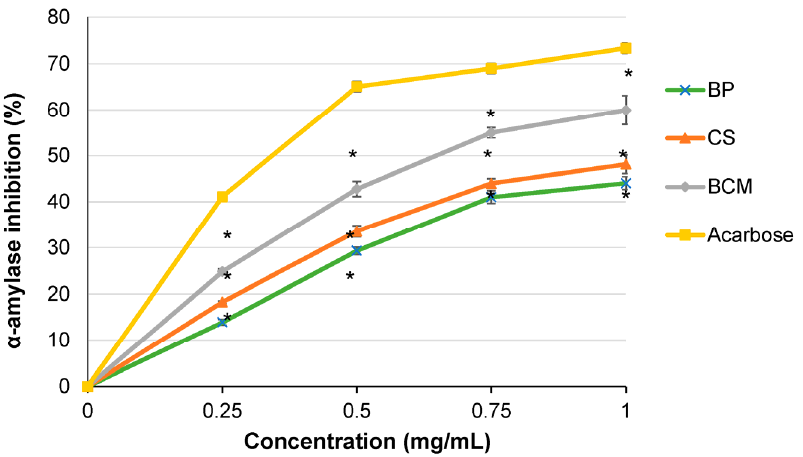
Figure 1. Inhibition of α -amylase activity in the presence of blueberry pomace extract (BP), chia seed extract (CS) and their mixture (BCM). Acarbose served as control. * p < 0.05, compared to control.